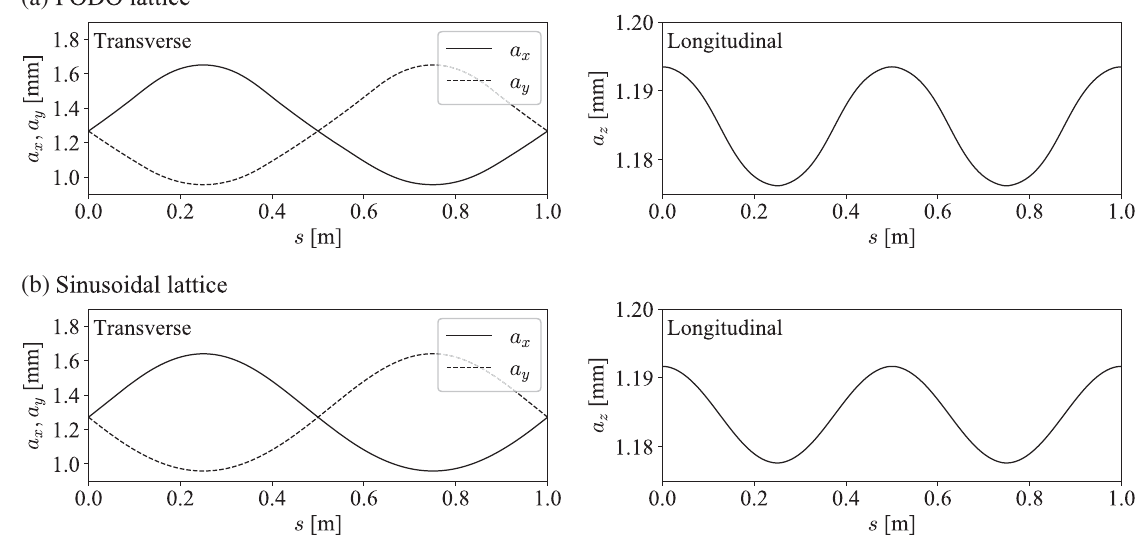
FIG. 2. Transverse and longitudinal rms envelopes matched to (a) the standard FODO lattice, and (b) the sinusoidal lattice in Fig. 1. The operating phase advances are set at ð μ 0 ⊥ ; σ 0 k Þ ¼ ð 55 ° ; 55 ° Þ in both cases. As an example, we have assumed an equipartitioned proton beam propagating at the kinetic energy of 10 MeV through a unit cell of 1 m long. The transverse rms emittance and tune depression are adjusted to ε ⊥ ¼ 1 . 0 π mm · mrad and η ⊥ ¼ 0 . 7